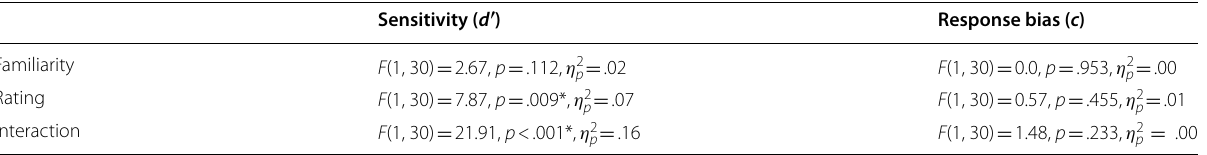
Table 4 Memory for masks (Question 2)